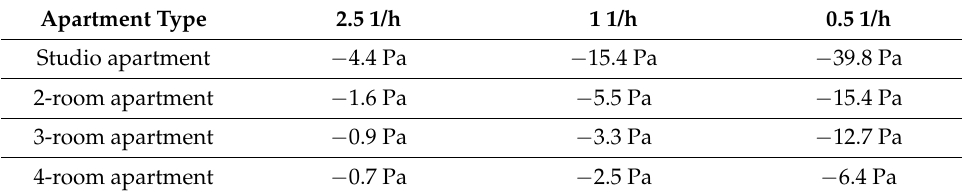
Table 4. The pressure difference in the apartments with different airtightness